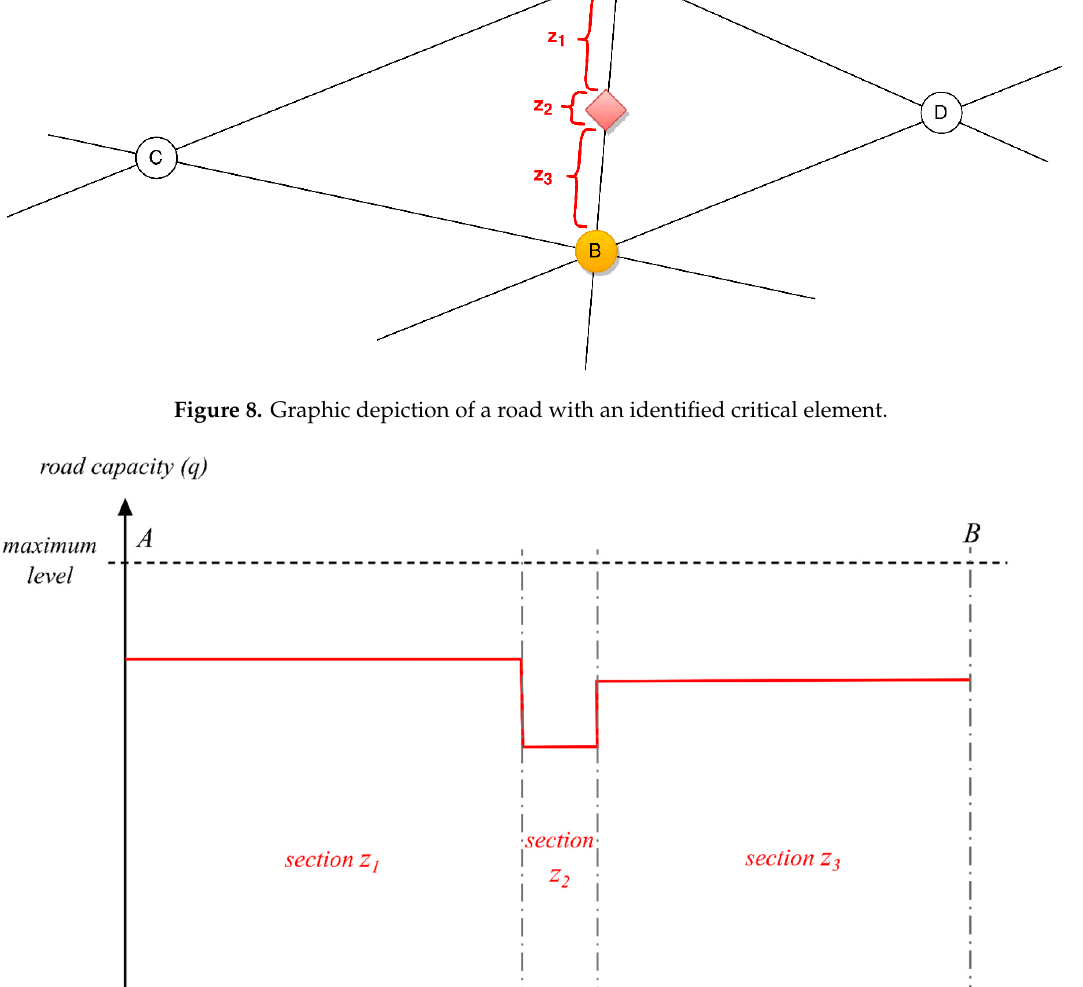
Figure 8. Graphic depiction of a road with an identified critical element.